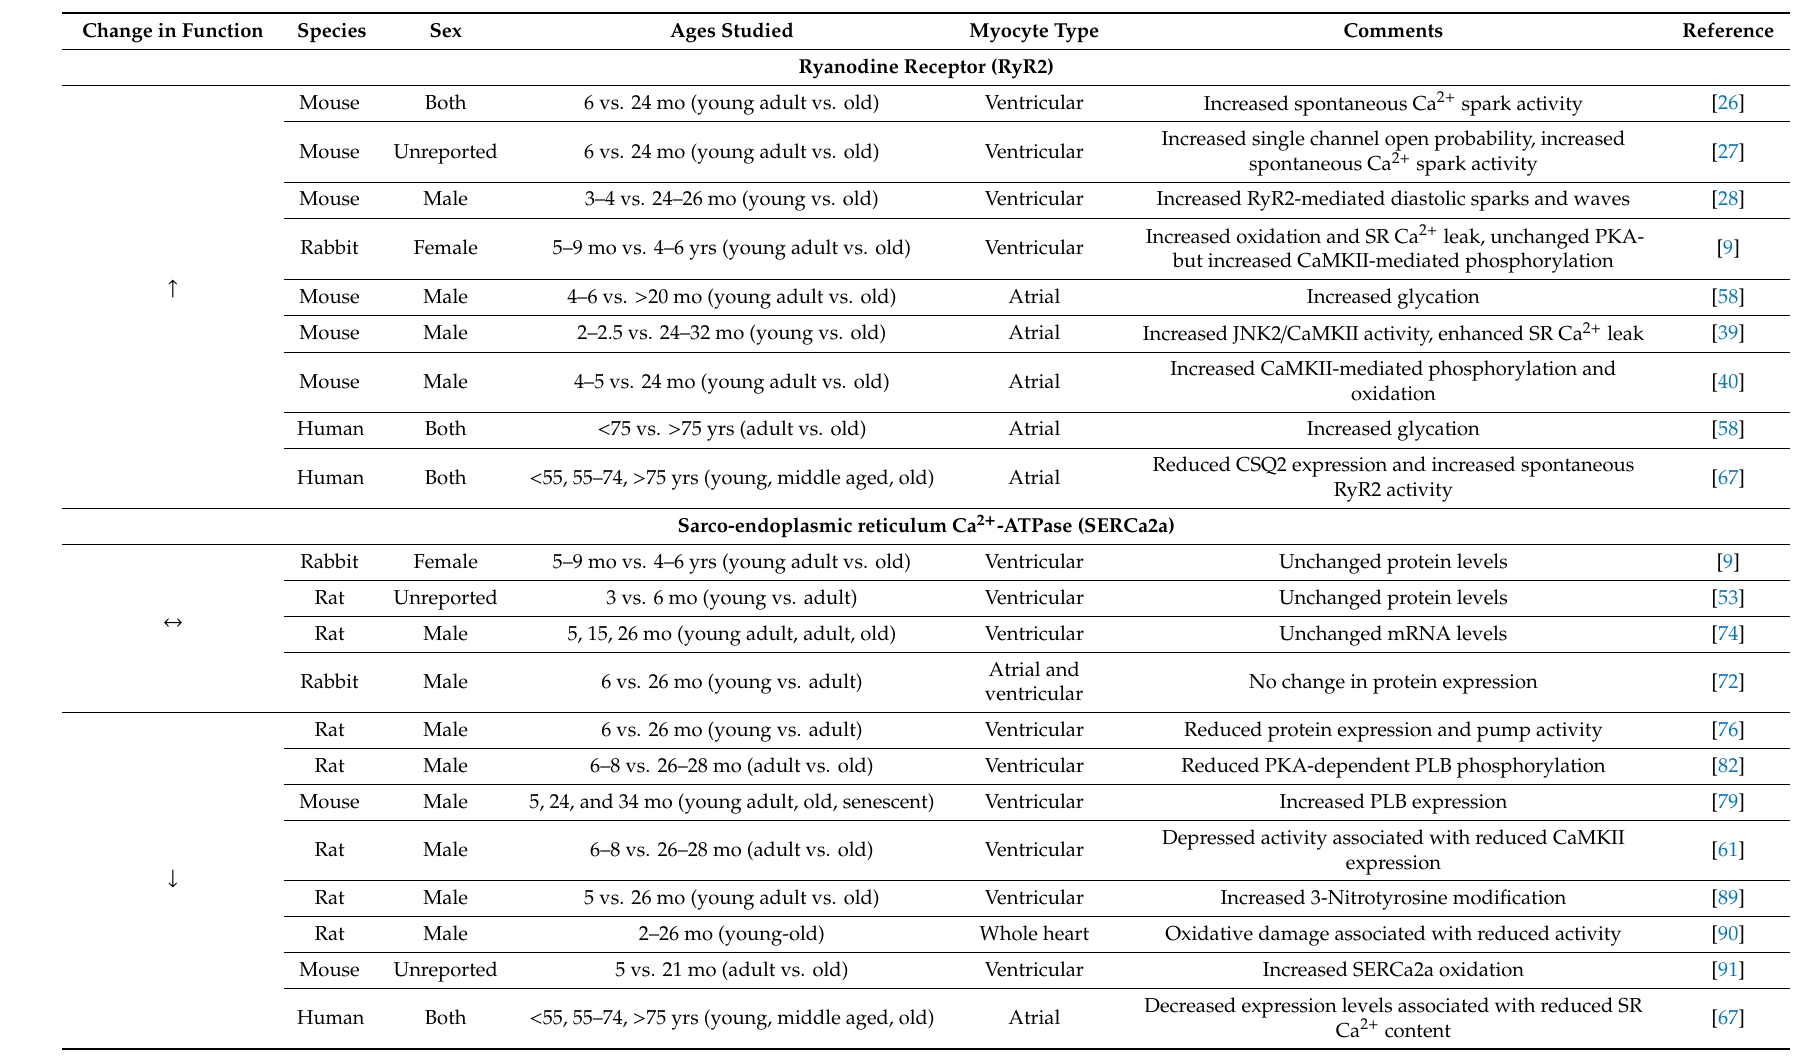
Table 1. Changes in excitation-contraction coupling proteins during cardiac aging. Abbreviations: mo—months old, yrs—years old. Change in